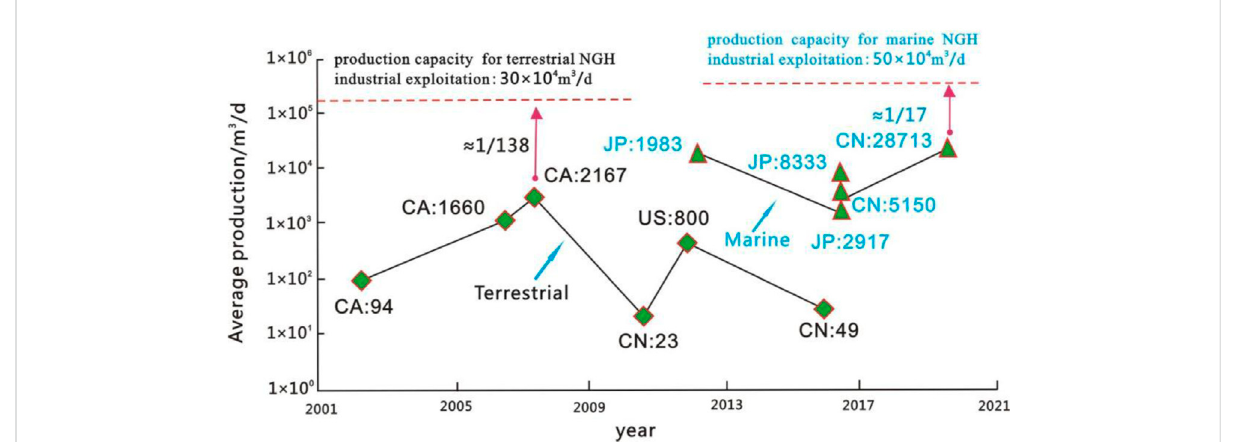
FIGURE 1 Average production capacity of NGH production tests in the world and the economic production rate for terrestrial and marine NGH industrial exploitation (Wu et al., 2020). CN means China, JP means Japan, CA means Canada, and US means the United States. The number after the country abbreviation represents the average daily production capacity of gas hydrates ’ production